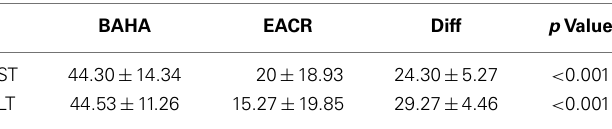
Table 5 | Comparison of short and long-term hearing gain between BAHA and EACR groups .